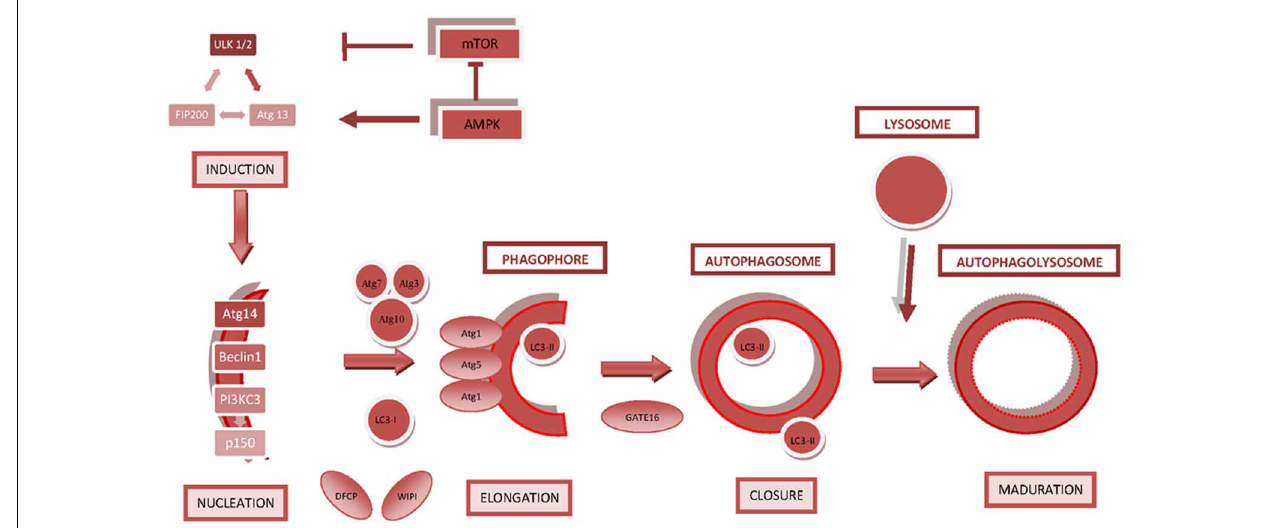
FIGURE 1 | Key regulatory molecules involved in autophagosome formation. The diagram shows the steps that lead to the formation and closure of the autophagosome and subsequent maturation into